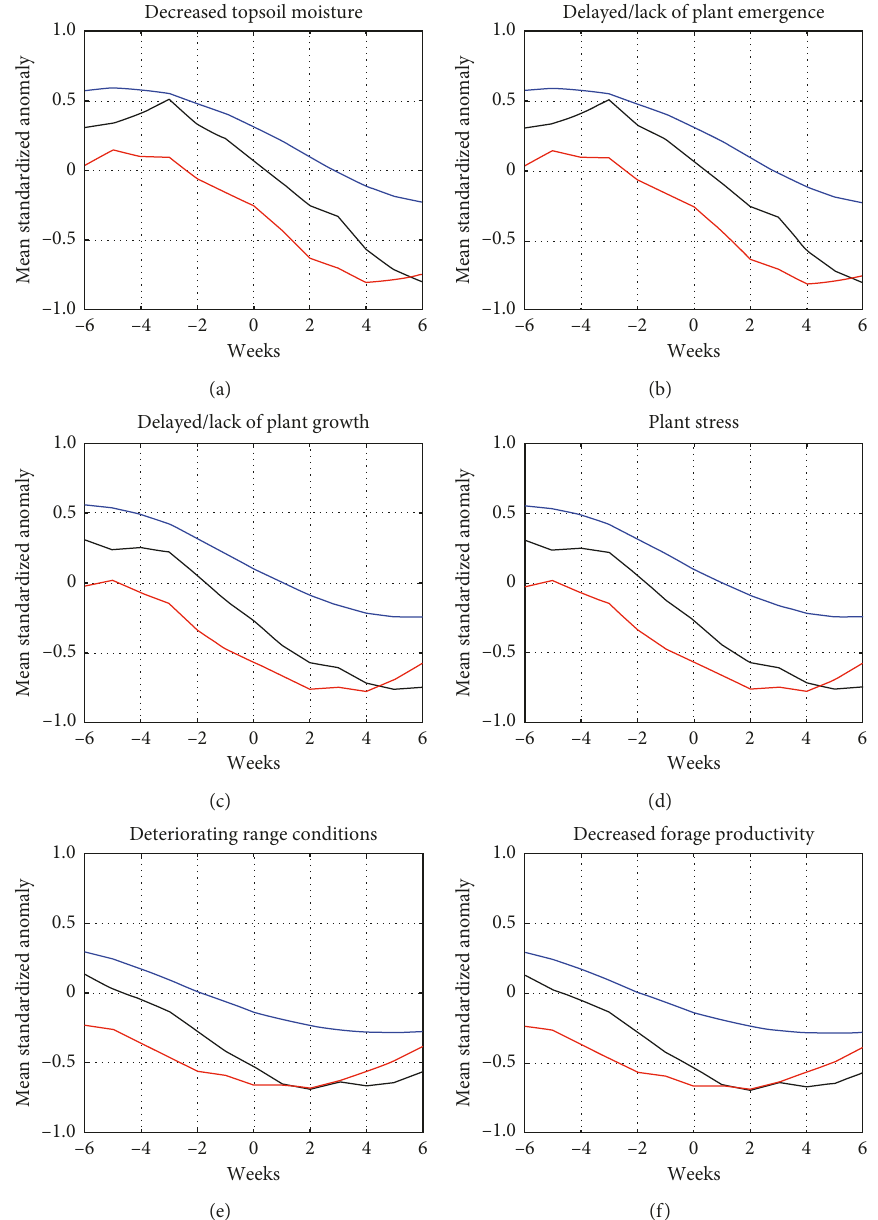
Figure 3: Time series showing the average condition depicted by anomalies in the ESI (black line) NLDAS TS (red line) and NLDAS TS (blue line) data sets at weekly intervals from six weeks prior to six weeks after the onset: (a) decreased topsoil moisture, (b) delayed/lack of plant emergence, (c) delayed/lack of plant growth, (d) plant stress, (e) deteriorating range conditions, and (f) decreased forage productivity as reported by the